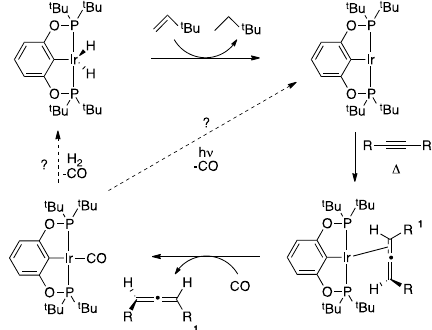
Figure 3. Partial 31 P{ 1 H}-NMR spectrum for 2b showing two diastereomers in